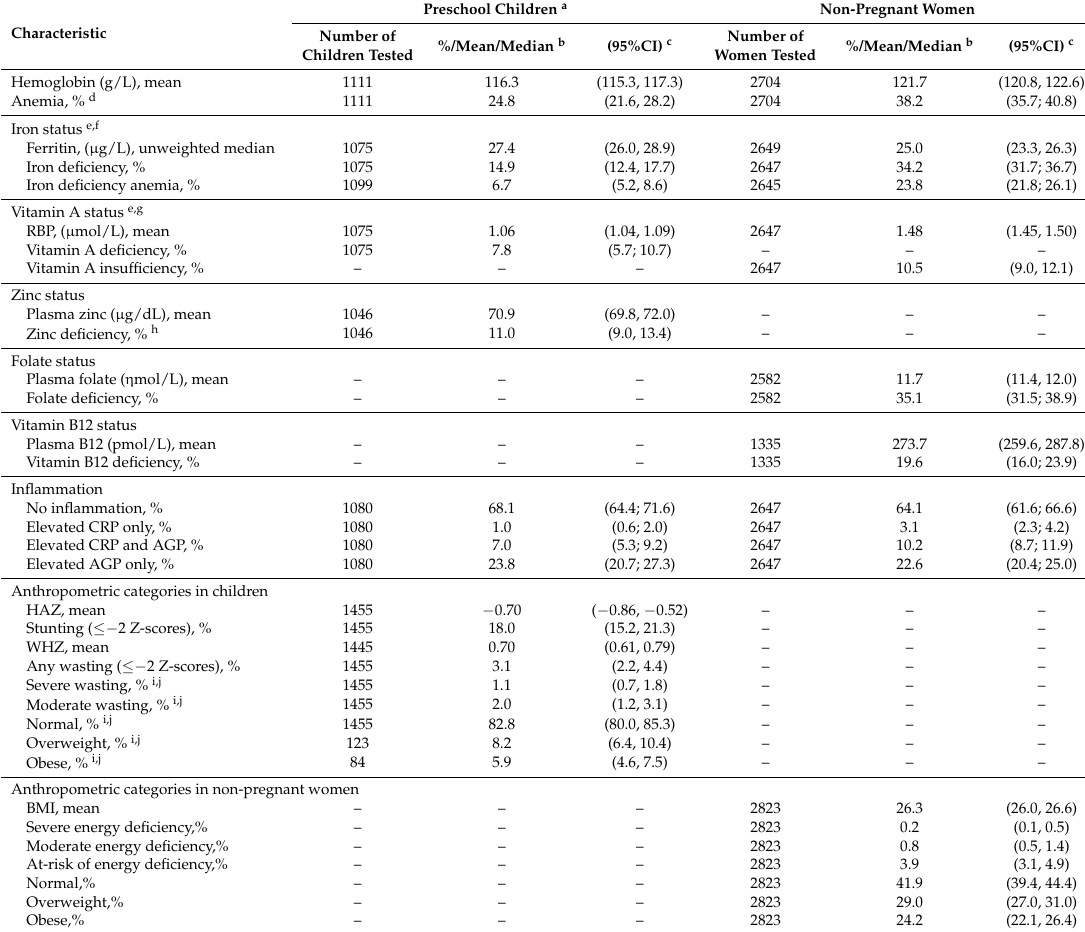
Table 2. Micronutrient and anthropometric indicators of preschool children and non-pregnant women of reproductive age, Azerbaijan